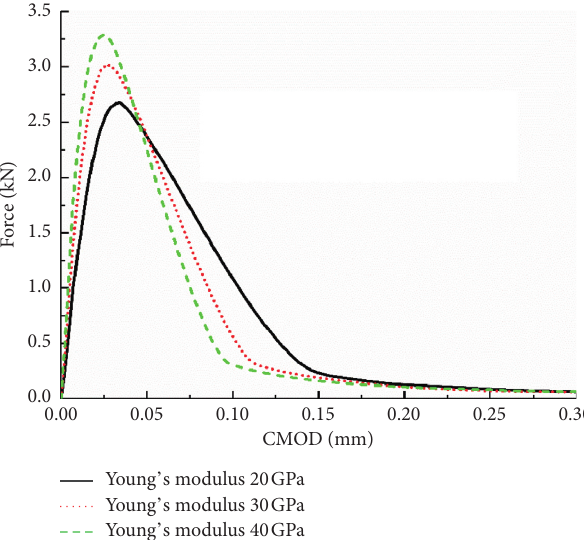
Figure 13: Effect of Young’s modulus on the P-CMOD